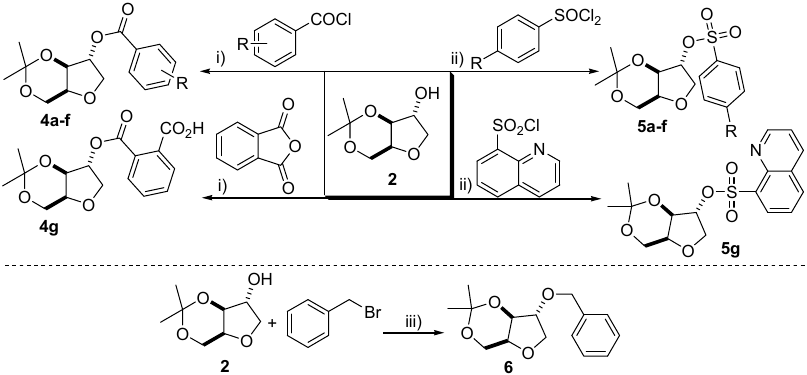
Table 1; (iii) NaH, THF, 0 ◦ C–room temperature, 24 h, Table 1. Product yields for compounds 4a – g and 5a – g . Table 1. Product yields for compounds 4a – g and 5a – g .